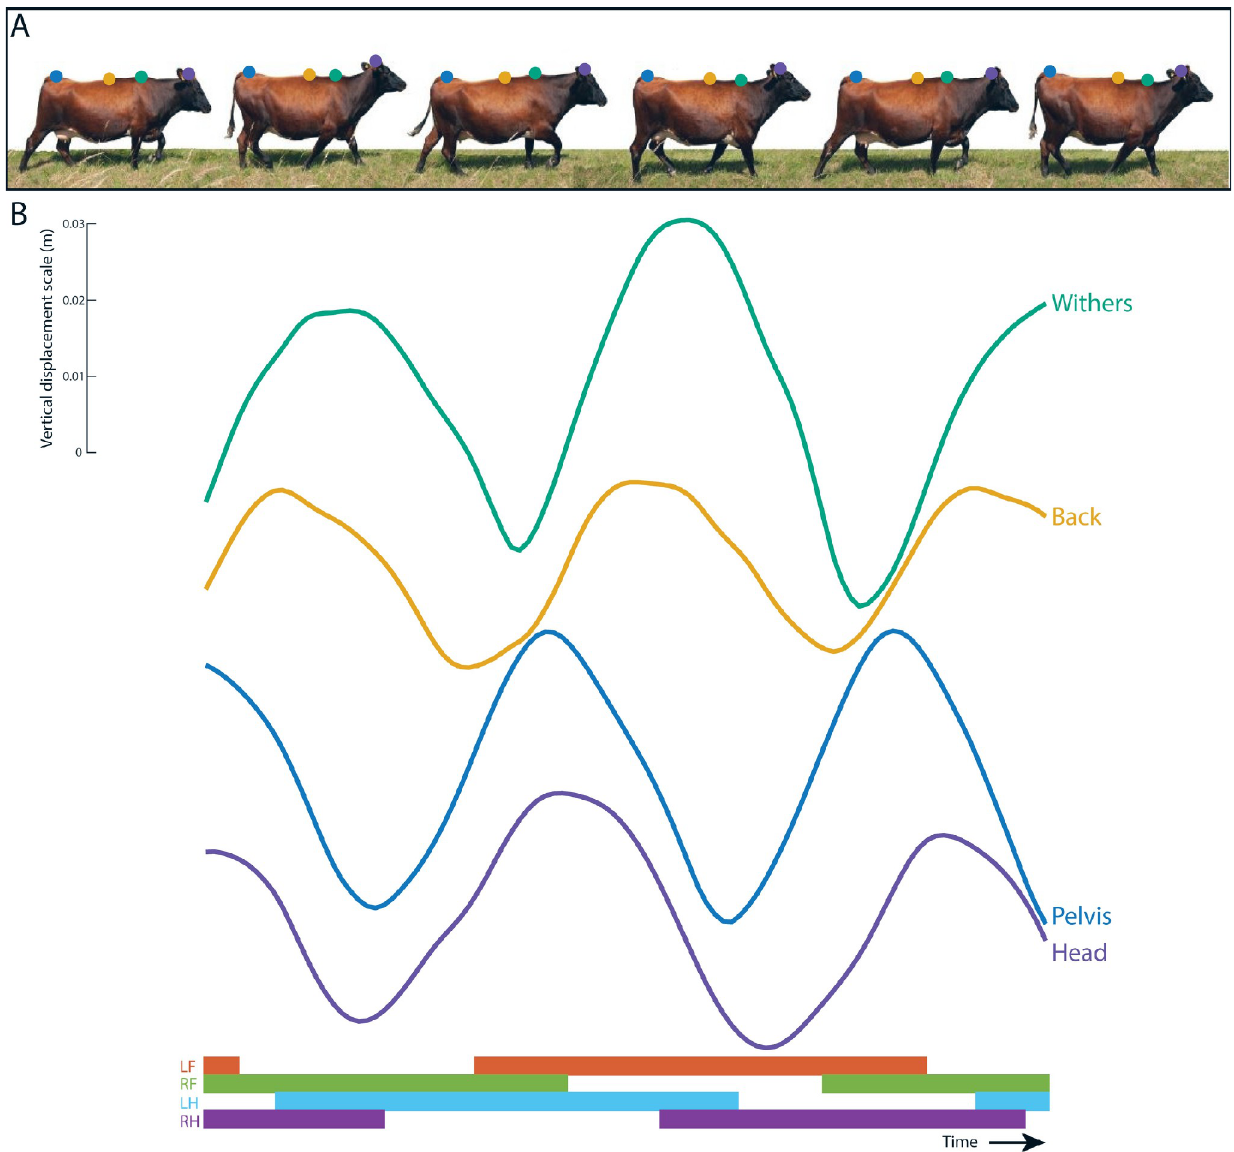
Fig 9. Upper body displacement curve and footfall pattern of normal walking gait. In A, different phases of a walking cow are shown with dots indicating the different sensor locations and their corresponding vertical signal pattern (green: withers, yellow: back, blue: sacrum and purple: head). In B, the median vertical displacement curves for the different sensor locations are shown from one cow, except for the head signal, which is selected from another cow for illustrative purposes. The synchronized footfall pattern is indicated underneath for all four limbs (orange: LF, green: RF, blue: LH and purple: RH). The scale of the signals is based on the true